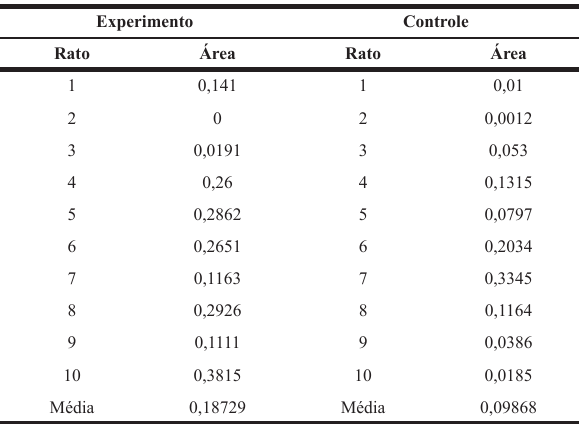
TABELA 2 - Planimetria do grupo experimento e